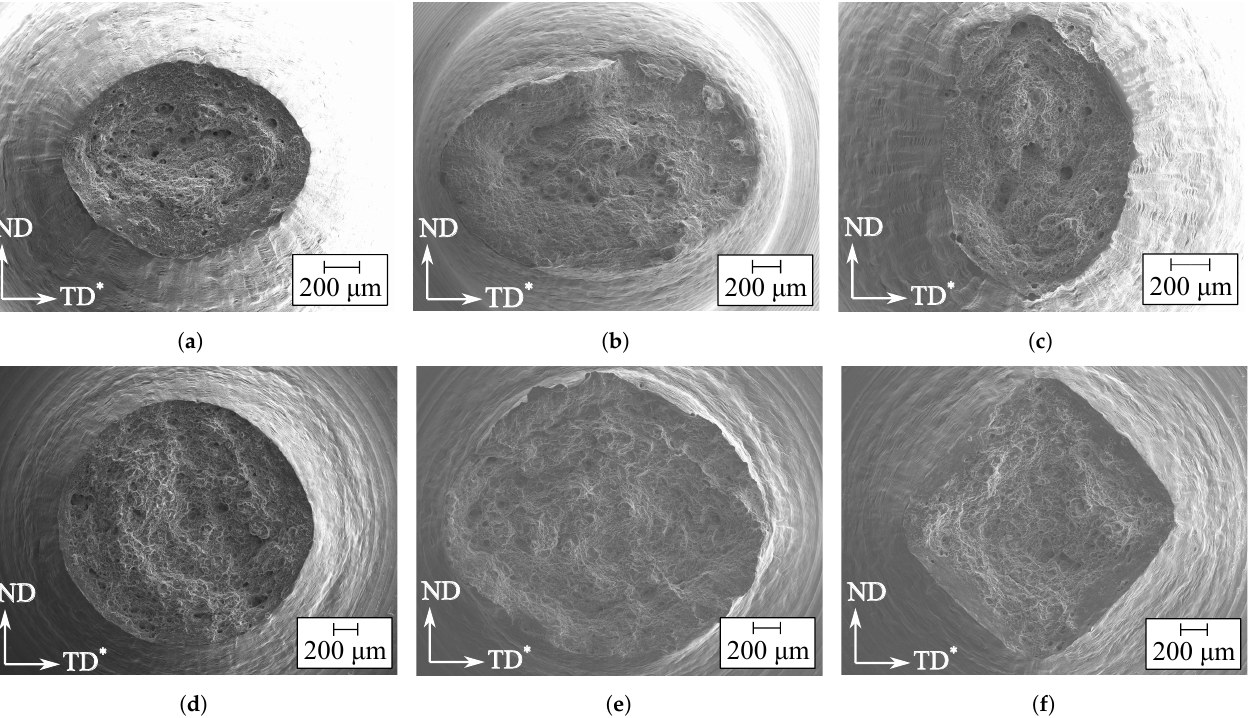
Figure 13. Fracture surfaces of representative tension tests for alloy AA6063. ( a ) Smooth, 0 ◦ , ( b ) Smooth, 45 ◦ , ( c ) Smooth, 90 ◦ , ( d ) R0.8, 0 ◦ , ( e ) R0.8, 45 ◦ , ( f ) R0.8, 90 ◦ .